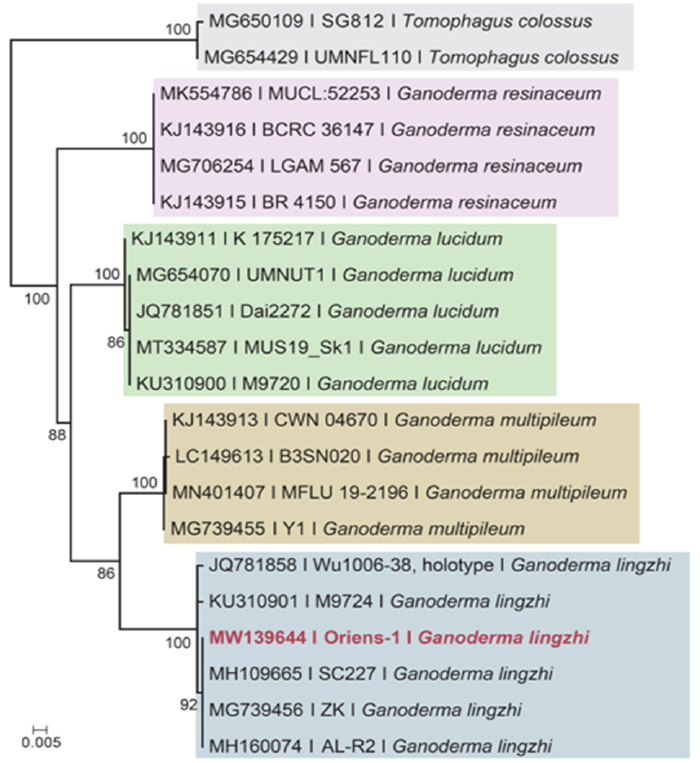
Figure 1. Maximum likelihood (RAxML) tree of ITS of the studied material (marked in red) and related specimens. Tomophagus colossus was served as outgroup. The scale bar indicates 0.005 expected changes per site per branch.